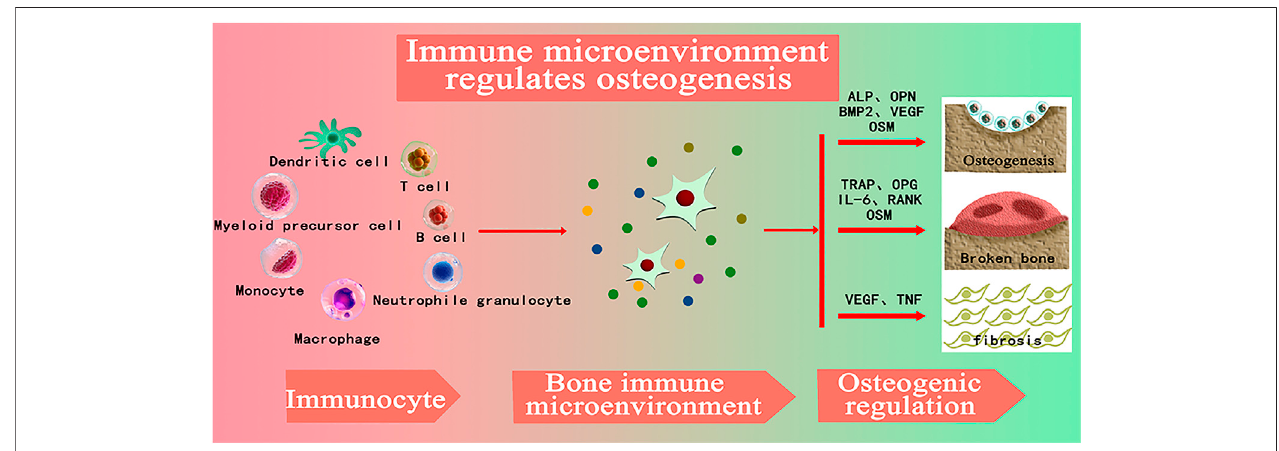
FIGURE 1 | (ALP: alkaline phosphatase; OPN: Bone bridge egg white, BMP-2: Bone morphogenetic protein-2, VEGF: vascular endothelial growth factor, OSM: tumor suppressant M, TRAP: Tartrate-resistant acid phosphatase, OPG: osteoprotectin; Il-6: Interleukin-6, RANK: nuclear factor κβ receptor activation factor, TNF: Tumor necrosis factor) (Chen et al., 2018)